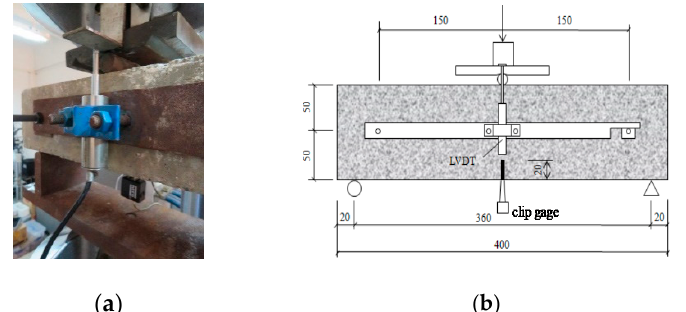
Figure 2. The three-point bending setup: ( a ) photo of three-point bending test; ( b ) schematic diagram of three-point bending test.